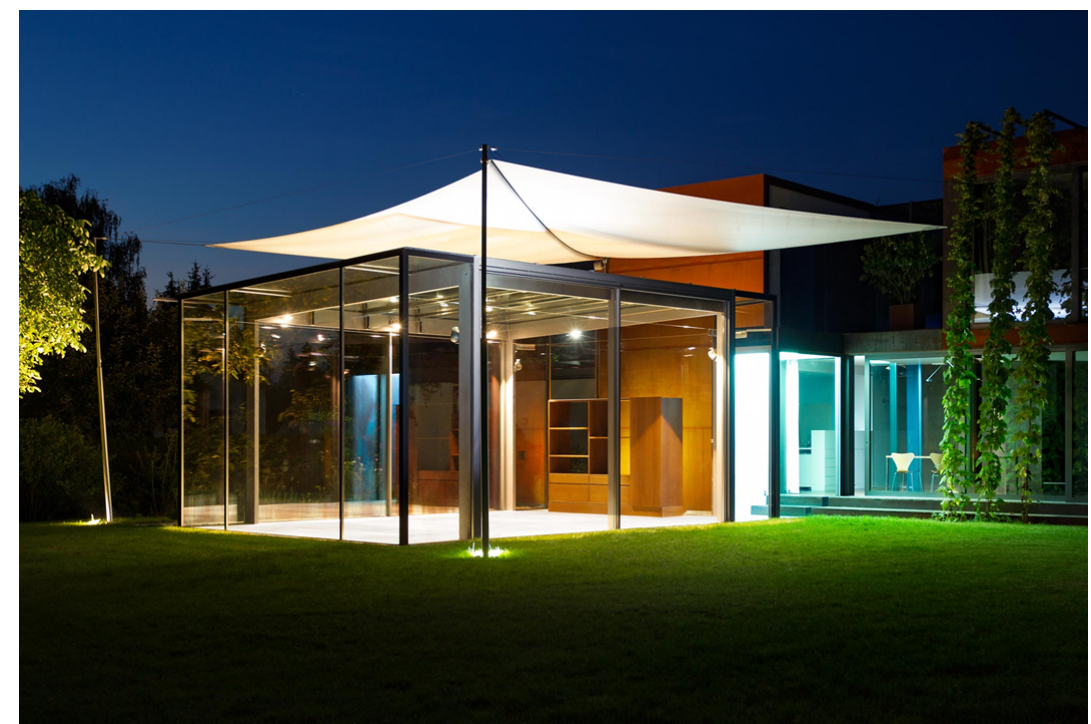
Fig. 1 Glass pavilion with main building in the background